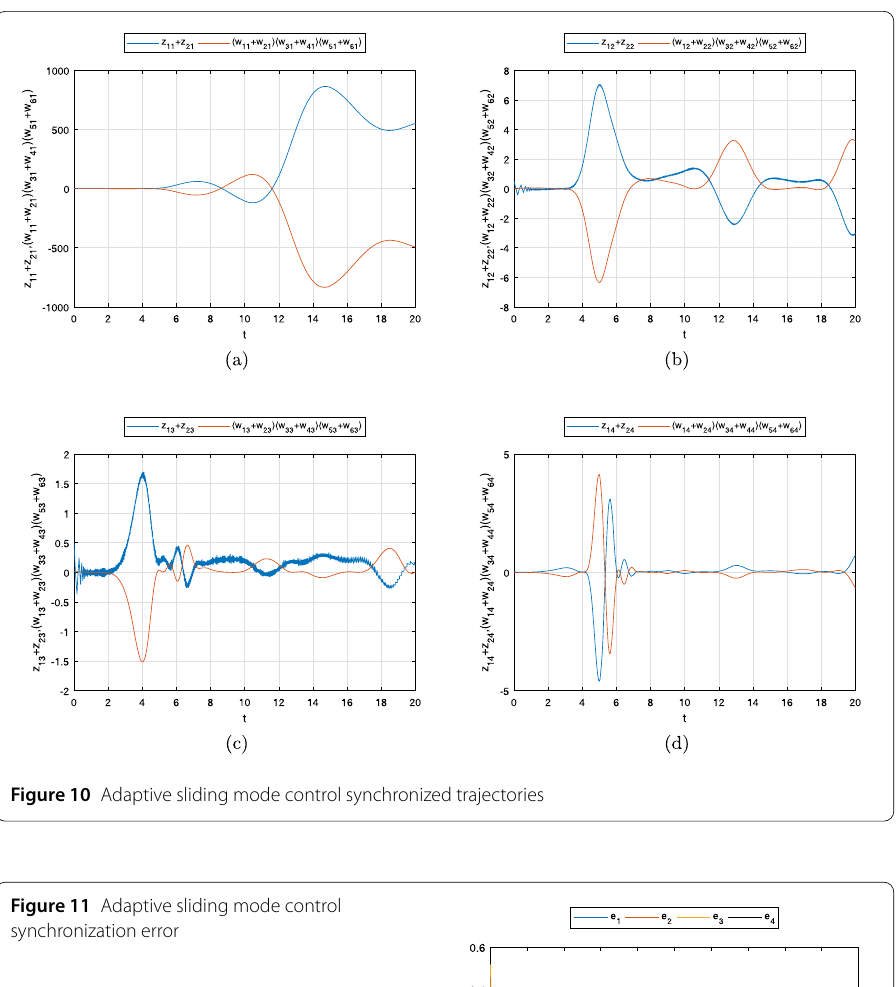
Figure 11 Adaptive sliding mode control synchronization